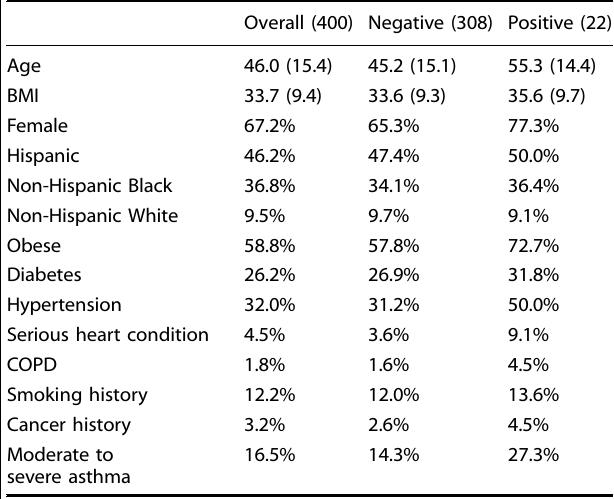
Table 1. Demographics and co-mordibities of the participants in the DeCODe phase 1